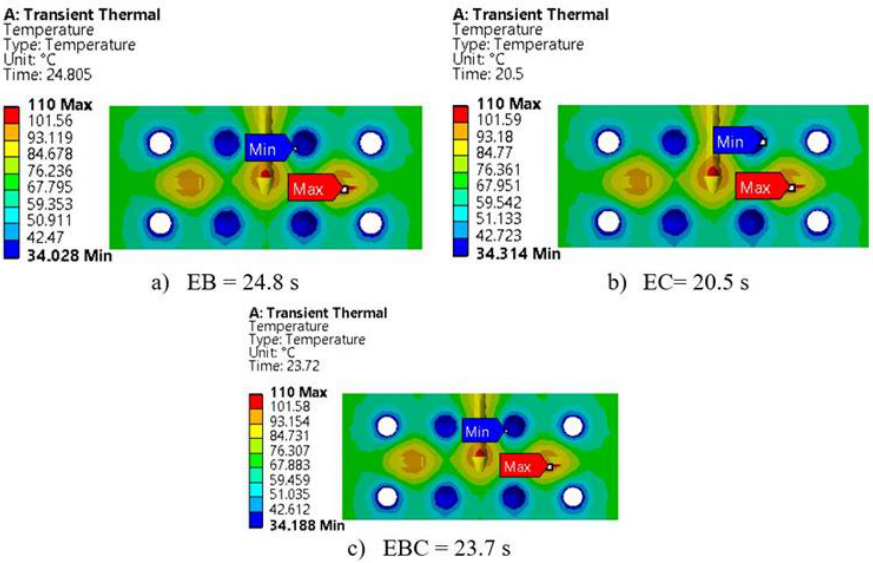
Figure 19. Transient thermal analysis at high compressive strength.